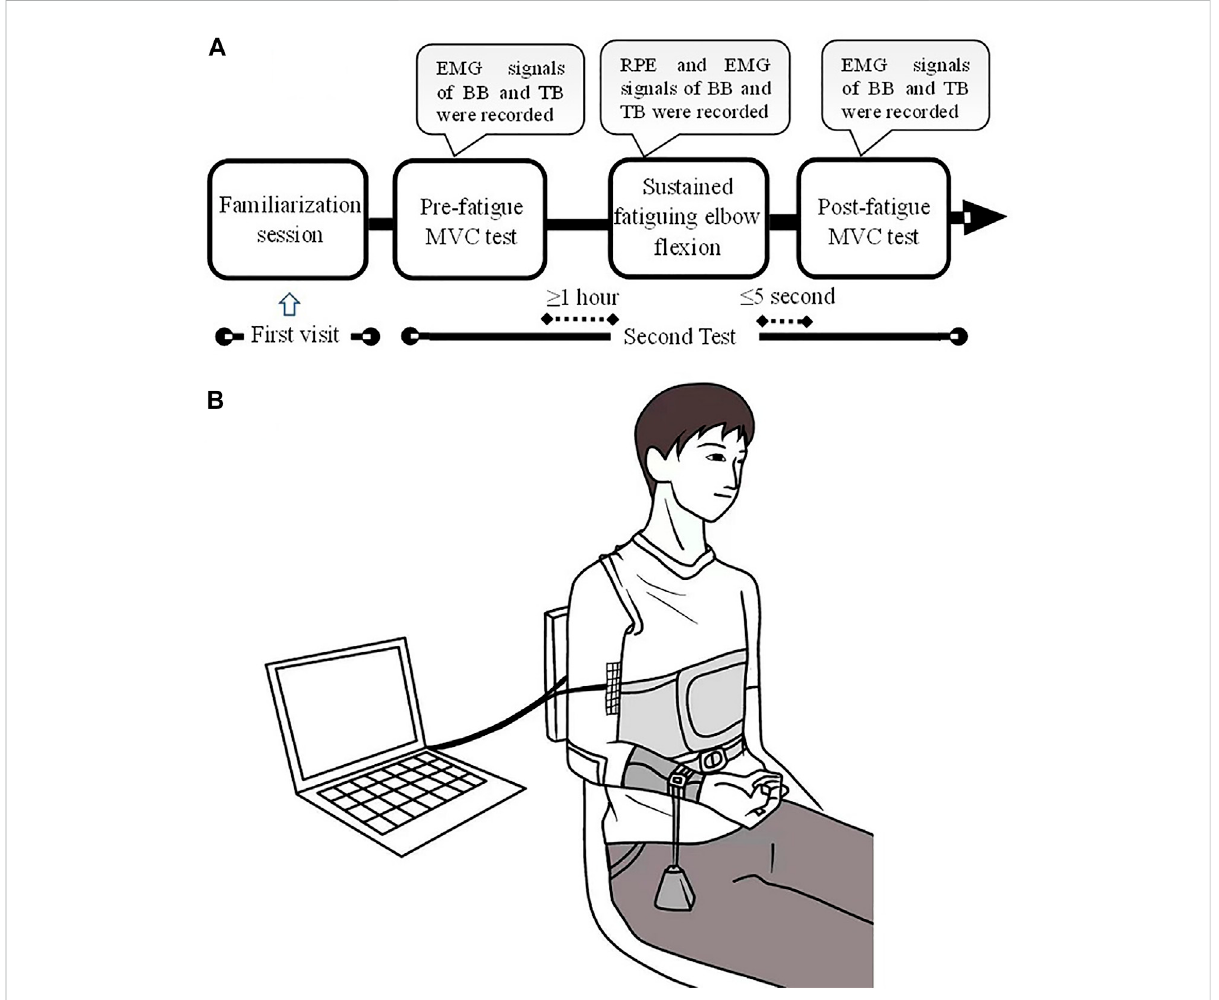
FIGURE 1 Experimental protocol and setup. A familiarization session was conducted for the fi rst visit of the laboratory. The formal experiment comprised of three procedures: pre-fatigue MVC test, sustained fatiguing elbow fl exion and post-fatigue MVC test (A) . During the experiment, the participants satwiththeupperarmverticallyplaced,andtheelbowanglewasmaintainedat~90 ° .Aweightwassuspendedfromthedistalpartoftherightforearm so as to produce a target of 10% MVC torque (B)